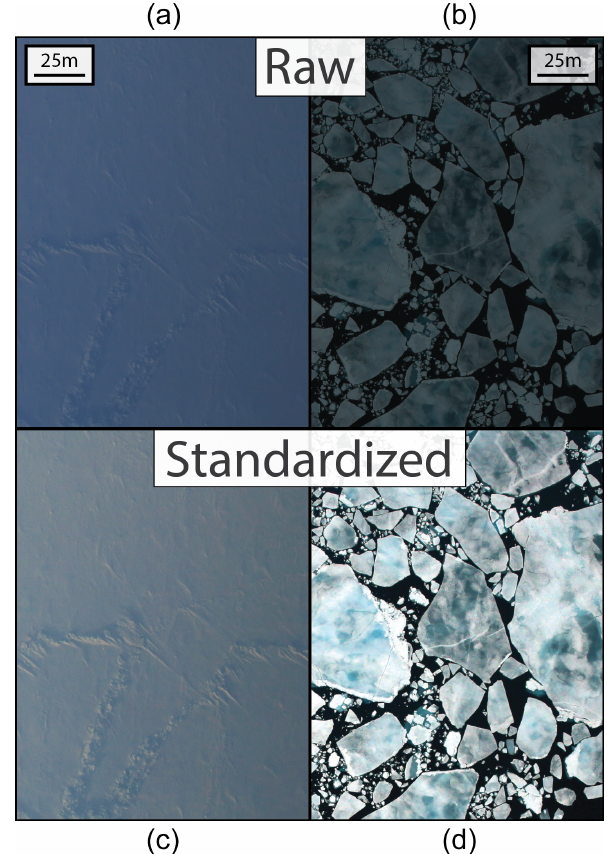
Figure 2. Demonstration of the image preprocessing steps. The raw images (a, b) have poor surface illumination and a blue hue which have both been removed in the standardized images (c, d)